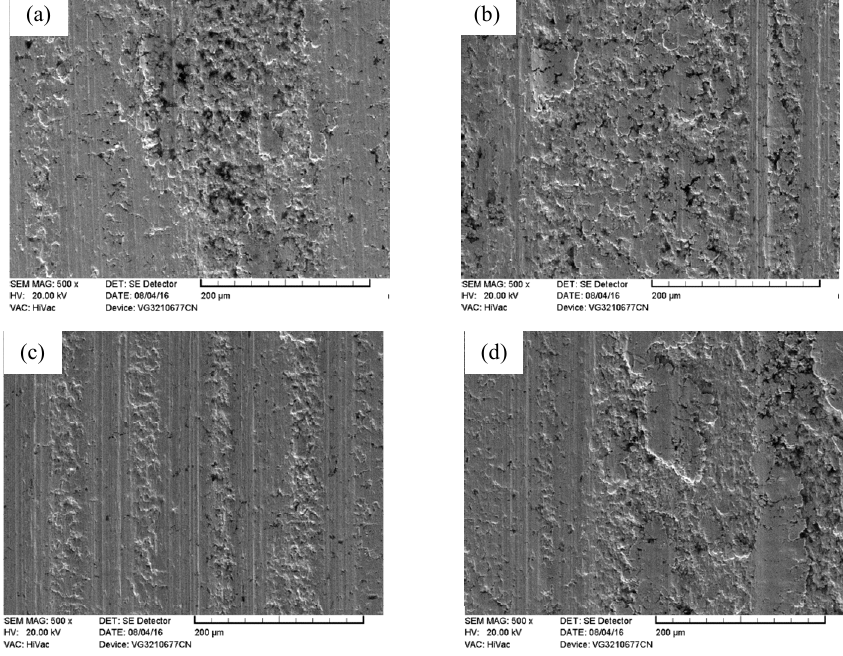
Fig. 15 Wear surface topography with the copper-chromium alloy disk: PV = (a) 15 MPa·(m/s), (b) 20 MPa·(m/s), (c) 25 MPa·(m/s), and (d) 30 MPa·(m/s), lead to adhesion